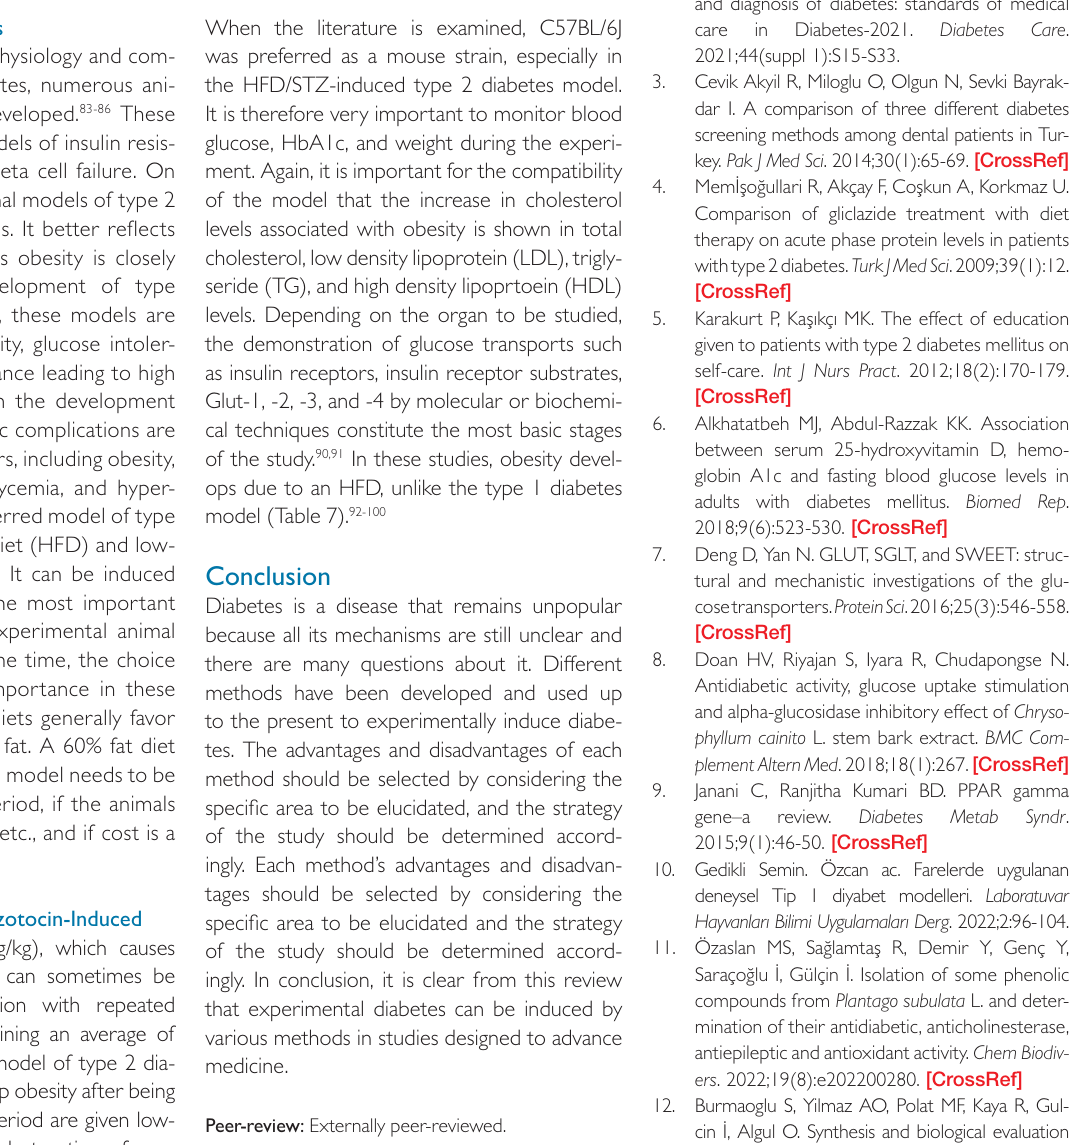
Models of Type 2 Diabetes